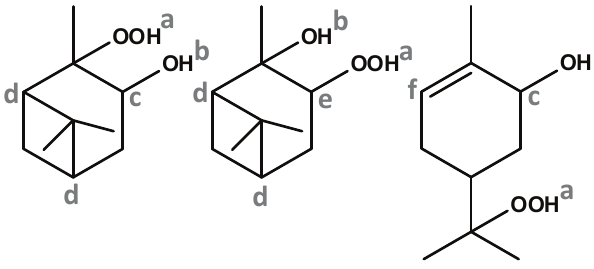
Fig. 6. Structure of the hydroxy hydroperxides formed from the low-NO x photooxidation of α -pinene, the most likely positions for reaction with OH are also shown; H-abstraction (a–e) and OH ad- dition (f)